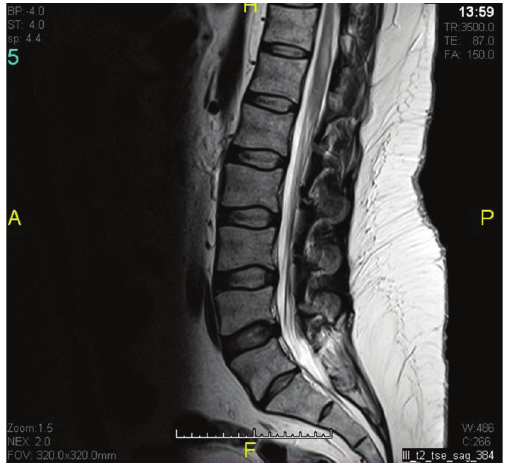
Figure 1: Focal area of high T2 signal change in lower spinal cord from T11-T12 level.